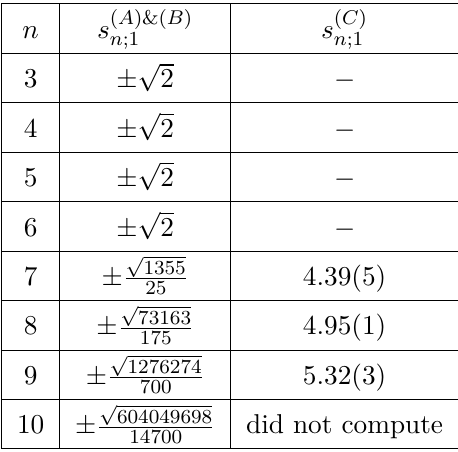
Table 2 . Leading corrections to the conformal spectra on branches ( A b ) , ( B b ) and ( C b )